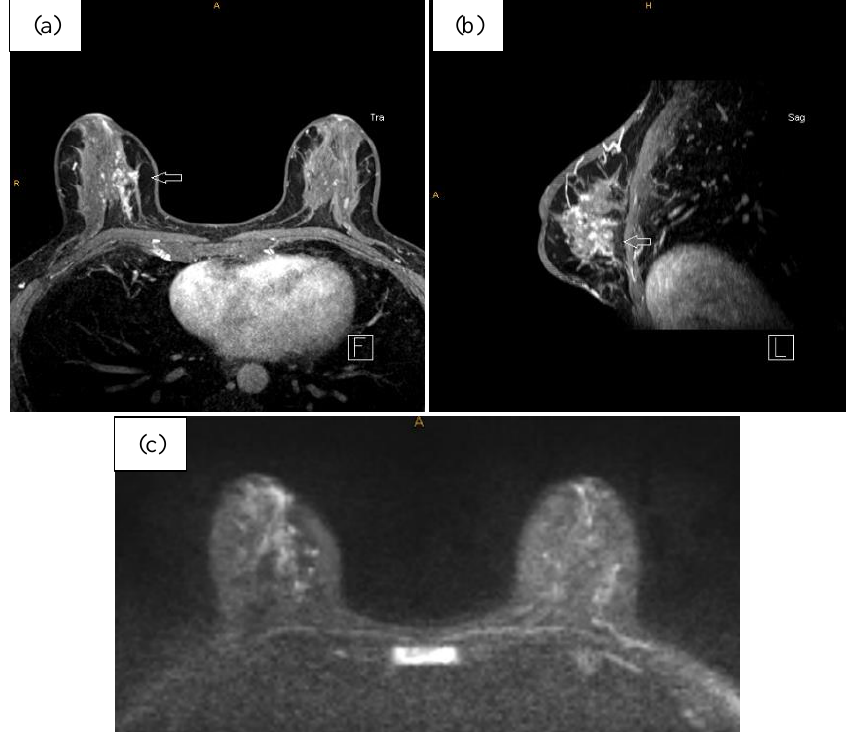
Figure 2. MRI of the breast: 45year-old woman with atypical ductal hyperplasia. Axial (a) and sagittal reconstructed (b) contrast-enhanced T1-weighted images show linear clumped enhancement in right breast (arrow). Corresponding diffusion- weighted image (b= 800 s/mm 2 ) (c) shows no evidence of restricted